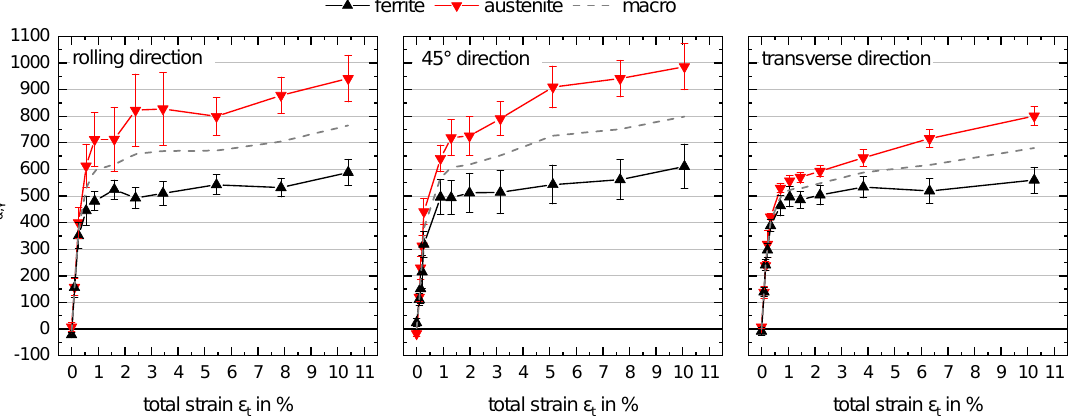
Figure 9. Evolution of the phase-specific loading stress (LS) for uniaxial loading in rolling direction RD ( left ), 45 ◦ direction ( centre ) and transverse direction TD ( right